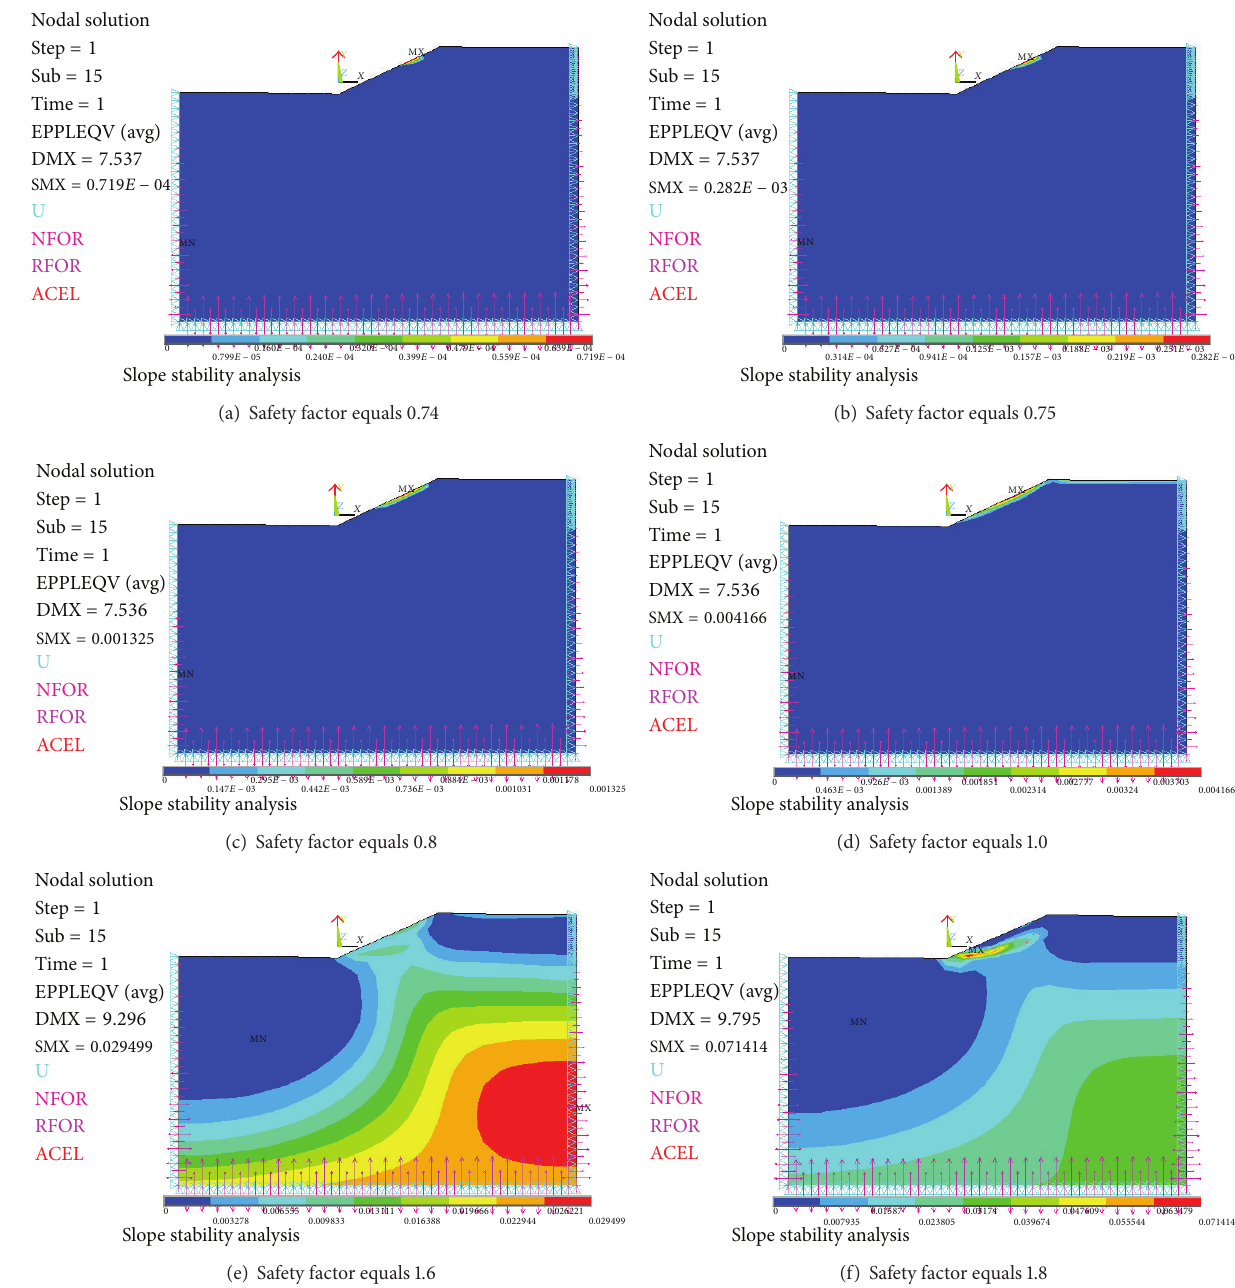
Figure 16: von Mises plastic strain occurs and develops.